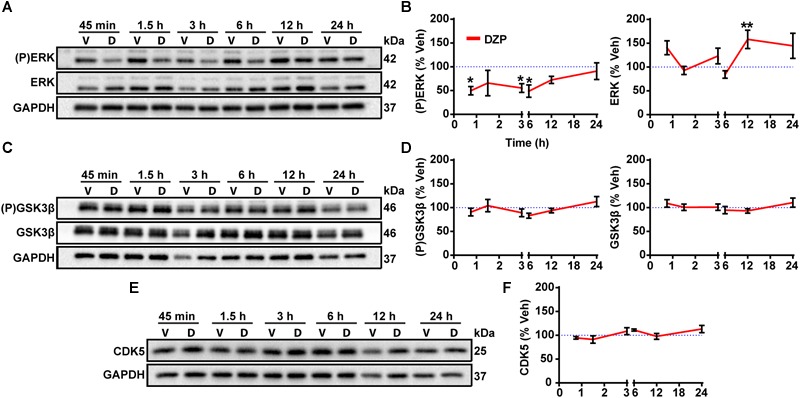
Gephyrin regulating kinases following DZP treatment. DIV 16 cortical neurons were treated with vehicle (V) or DZP (D) at multiple time points. Known kinase regulators of gephyrin synaptic clustering were tested for total protein levels and activation status with phospho-specific antibodies as indicated. (P)ERK and total ERK (A,B), (P)GSK3β and total GSK3β (C,D) and CDK5 (E,F) western blot and quantification (n = 4 independent cultures). DZP strongly inhibited ERK phosphorylation across multiple time points while GSK3β activation and total levels did not change. CDK5 total levels were also unchanged by DZP treatment. (∗p ≤ 0.05, ∗∗p < 0.01, Two-way ANOVA followed by Sidak’s multiple comparisons test; error bars ± s.e.m).